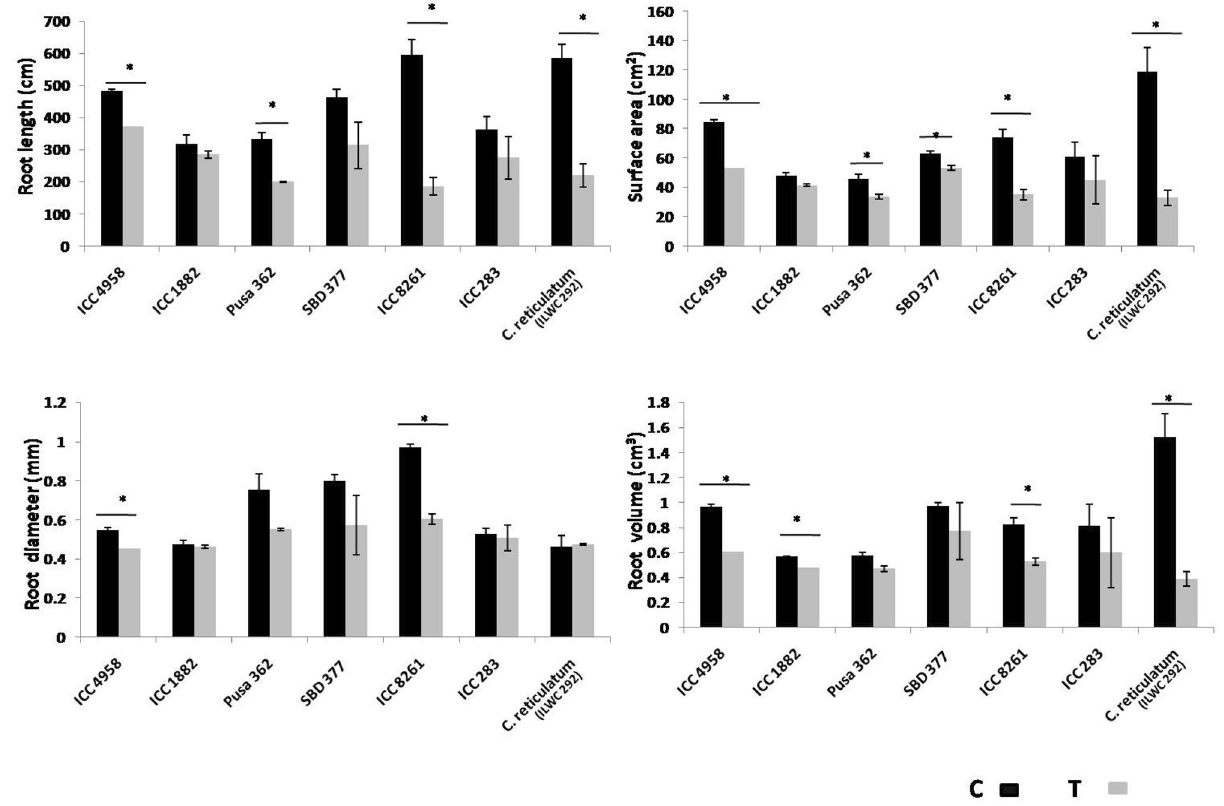
Figure 11. Differences in root morphological traits (root length, surface area, root diameter and root volume) between the control, well-watered (C24) and drought stress treated (T24) plants, for the seven genotypes used in the study. The data for the traits was recorded on 117 DAS. ILWC 292 belongs to the wild species C. reticulatum , while the remaining six genotypes belong to the cultivated chickpea species, C. arietinum . ICC 4958, ICC 8261, ILWC 292, Pusa 362 are drought tolerant and ICC 1882, SBD 377 and ICC 283 are drought sensitive. Error bars indicate standard errors of means of three biological replicates/genotype/treatment (n = 3). Statistical significance of differences in means, was tested by Student’s t-test. The *symbol above horizontal lines (C and T) represent significant difference at p <